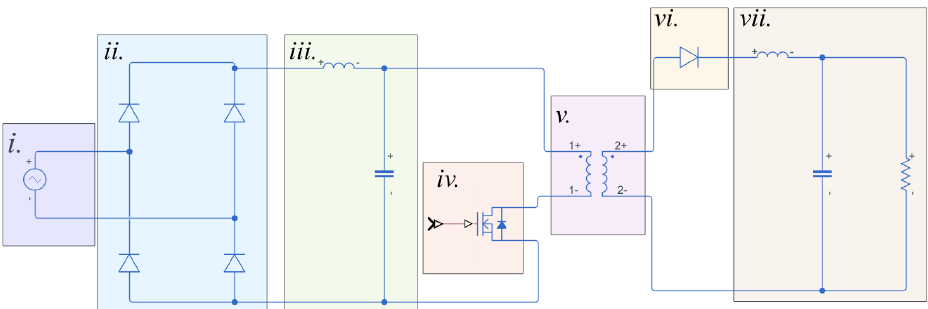
Figure 1. Typical SMPS circuitry—shaded areas represent sections as defined by i. – vii.